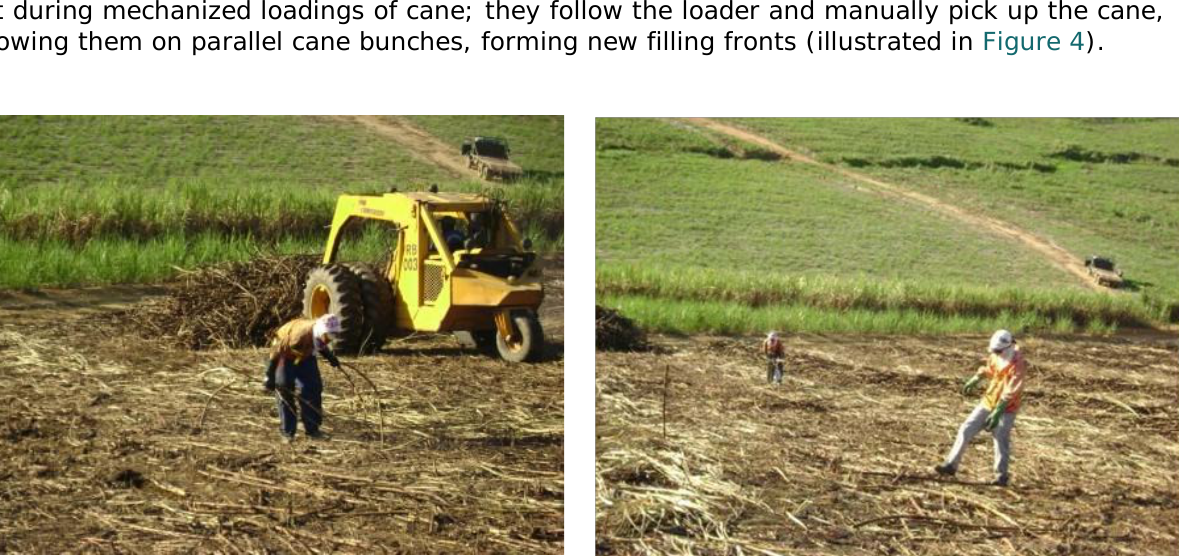
Figure 4. Forming new filling fronts from cut cane (working activity